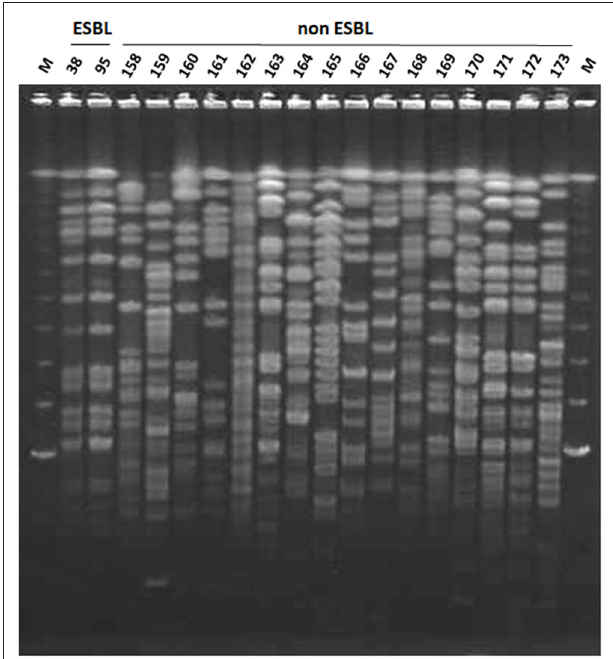
FIGURE 3 | Pulsed-field gel electrophoresis (PFGE) patterns of Xba I-digested genomic DNA of ESBL-producer and non-producer K. oxytoca strains from farm W. Lanes: 38, strain Ko38; 95, strain Ko95; 158, strain Ko158; 159, strain Ko159; 160, strain Ko160; 161, strain Ko161; 162, strain Ko162; 163, strain Ko163; 164, strain Ko164; 165, strain Ko165; 166, strain Ko166; 167, strain Ko167; 168, strain Ko168; 169, strain Ko169; 170, strain Ko170; 171, strain Ko171; 172, strain Ko172; M, lambda